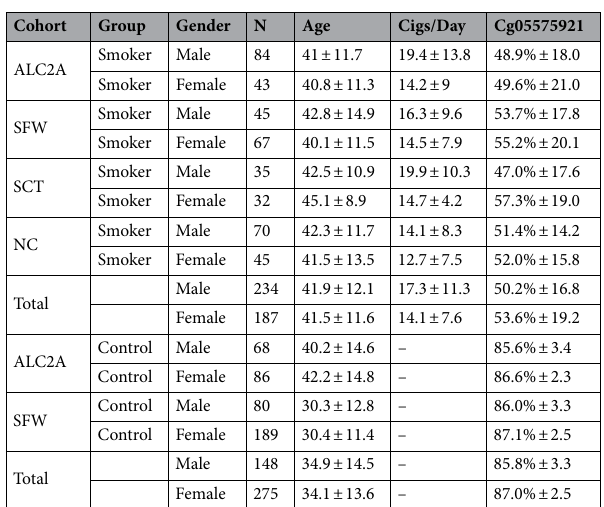
Table 1. Key clinical characteristics of subjects in each cohort.